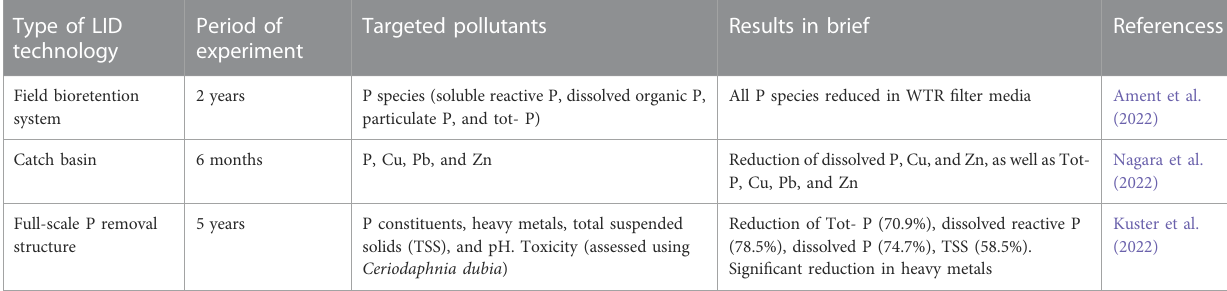
TABLE 5 Low Impact Development facilities including water treatment residuals (WTR) as fi lter media. Type of LID